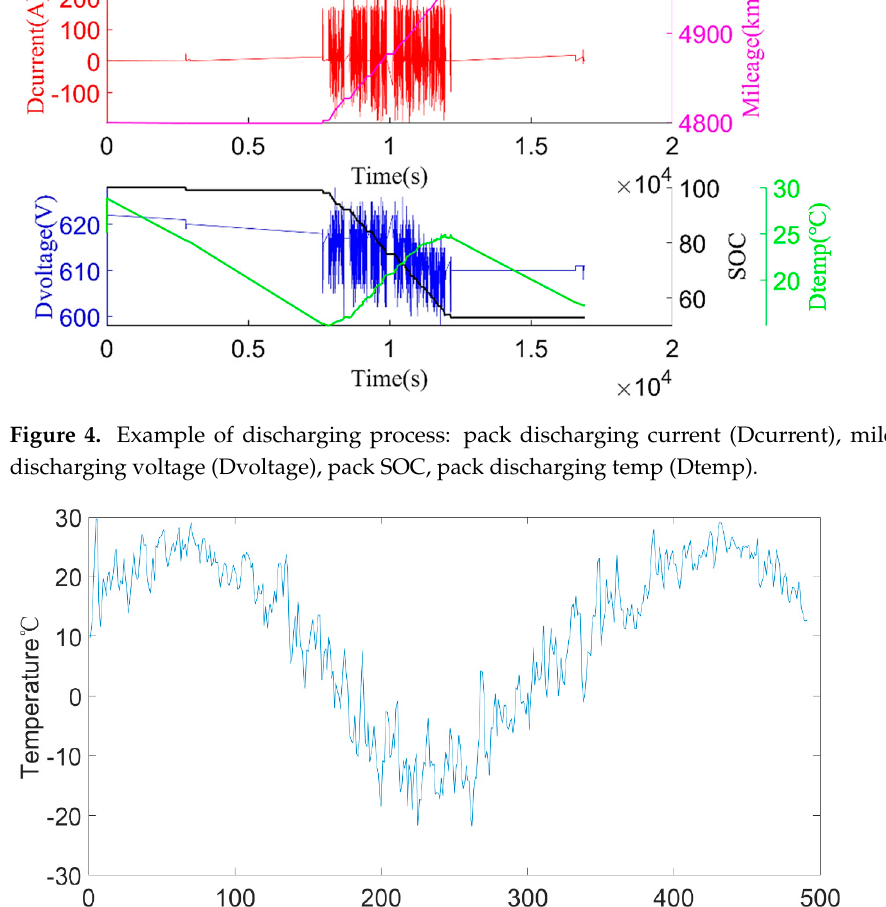
Figure 4. Example of discharging process: pack discharging current (Dcurrent), mileage, pack dis- charging voltage (Dvoltage), pack SOC, pack discharging temp (Dtemp).